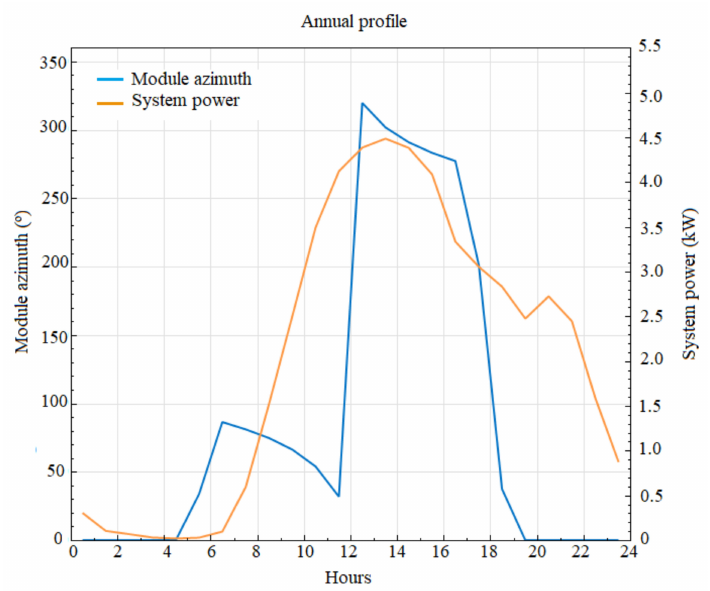
Figure 20. Variation of the module’s azimuth angle with the sun